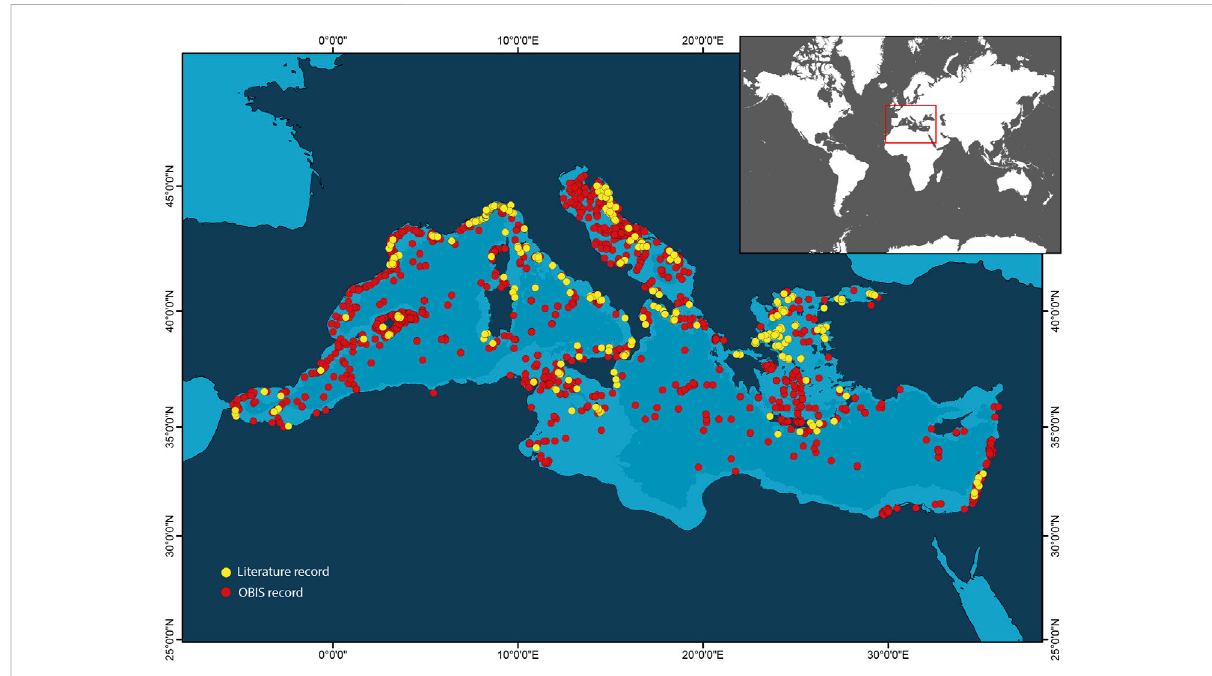
FIGURE 1 Map showing the distribution of available information on mesophotic habitats and taxa in the Mediterranean Sea. Yellow and red dots refer to the literature records (scienti fi c articles and reports) and species occurrences from OBIS repository (obis.org),